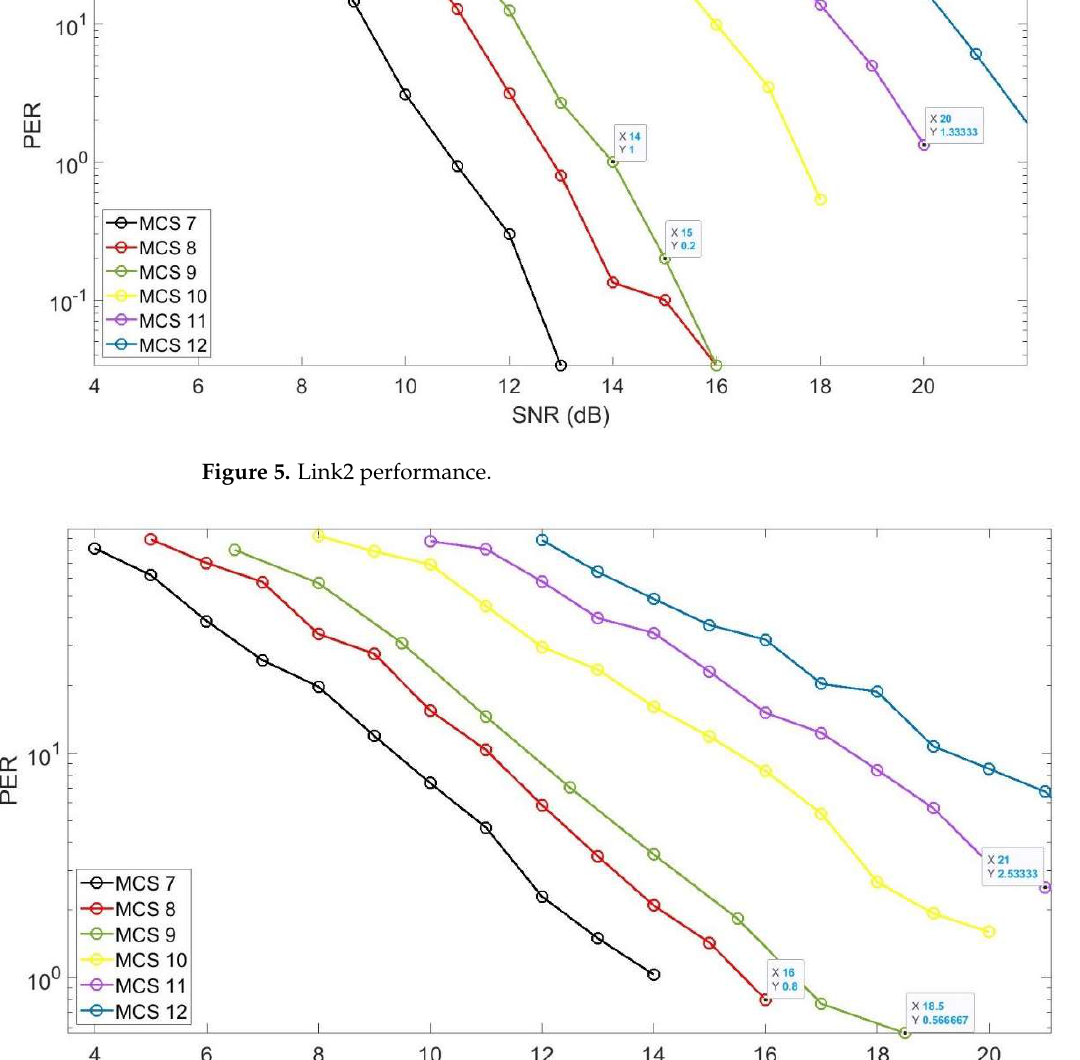
Figure 6. Link3 performance.